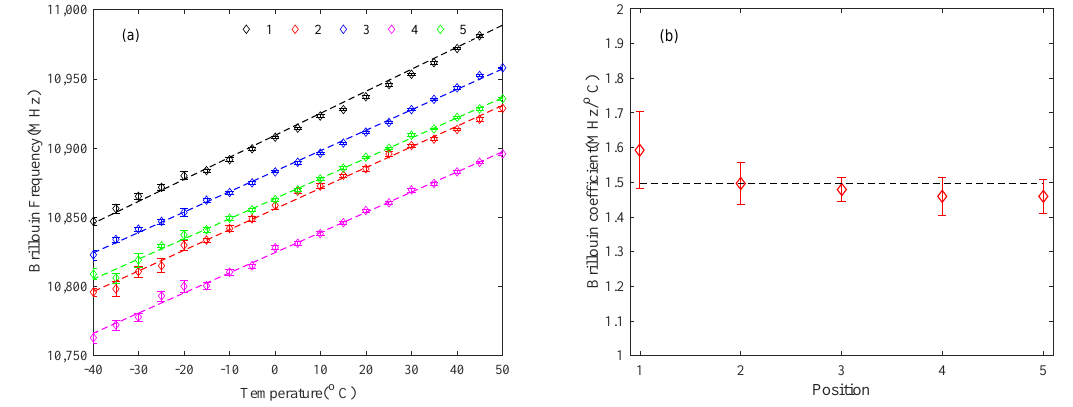
Figure 5. ( a ) Brillouin frequency variation with the temperature of Fiber B at different positions of the rail specimen; ( b ) Brillouin coefficient at different positions in the vertical direction of the